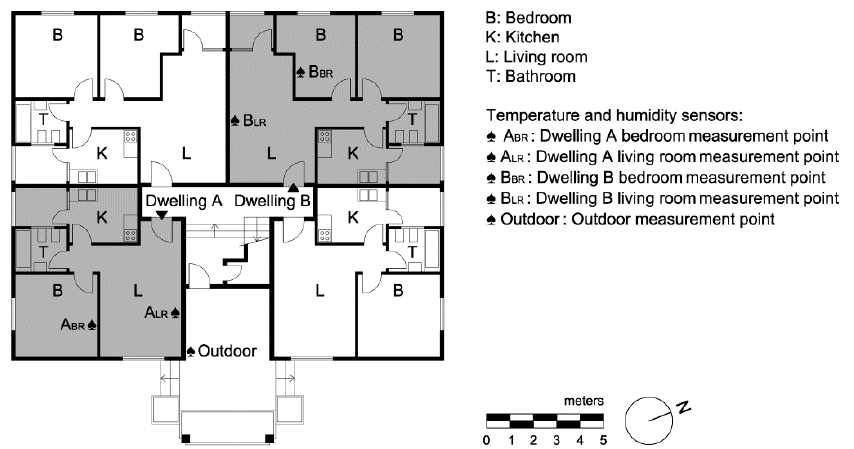
Figure 2. Case study: ground floor plan with sensor positioning in Dwellings A and B.